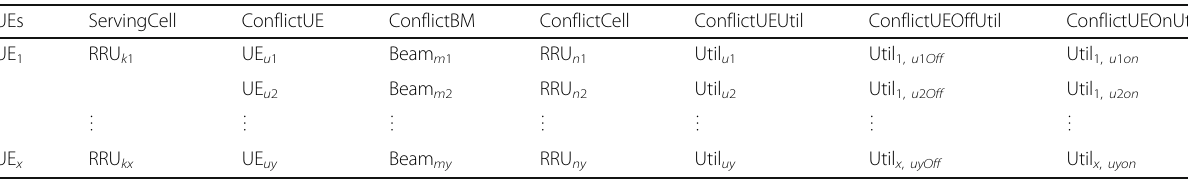
Table 1 Forbidden relationship